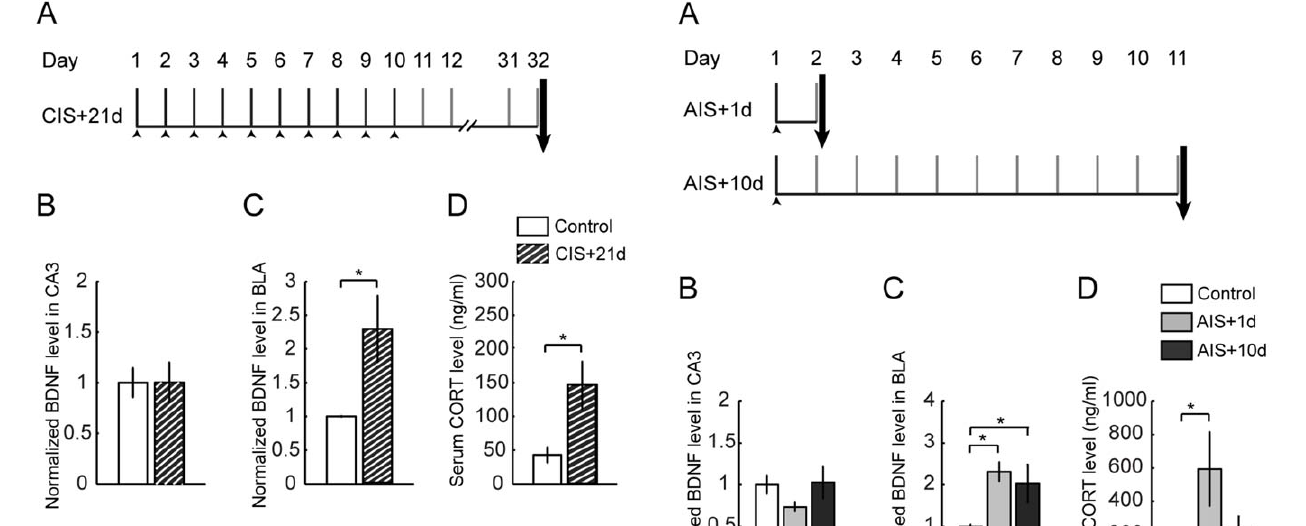
Figure 2. Contrasting profiles of BDNF in CA3 and BLA in response to recovery from chronic stress. Data are presented as mean 6 SEM A Experimental design of 21 days of recovery from chronic stress paradigm (CIS + 21d). B BDNF expression in area CA3 comes back to control levels post recovery from chronic stress (Control, n=6; CIS + 21d, n=6), C Chronic stress induced up regulation in BDNF expression in BLA persists even after twenty one days of recovery (Control, n=4; CIS + 21d, n=6). BDNF expression profile is normalized to respective control level. D The up regulation of serum corticosterone levels persists even after recovery from chronic stress (Control, n=7; CIS + 21d, n=6). Significant differences *, p , 0.05; Unpaired, two-tailed, Student’s t-test was used to compare stress and control